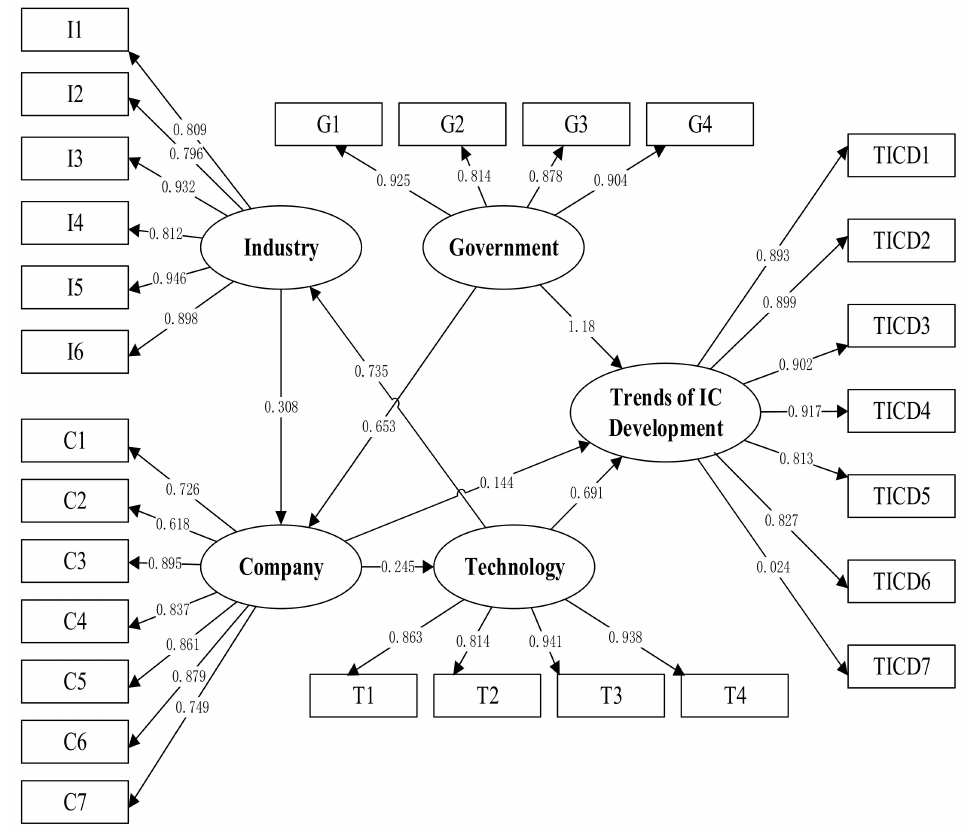
Figure 5. Influencers acting on the IC development mechanism